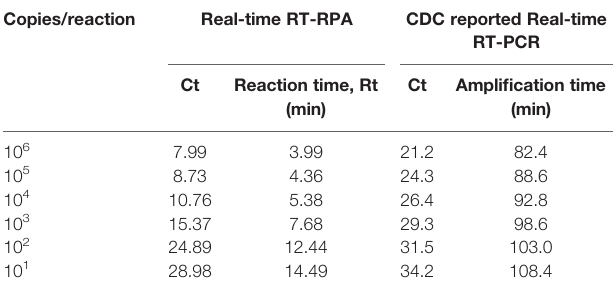
TABLE 3 | Comparative evaluation of the sensitivity performance and turnaround time between Real-time reverse transcription recombinase polymerase ampli fi cation (RT-RPA) and CDC reported Real-time RT-PCR assay.